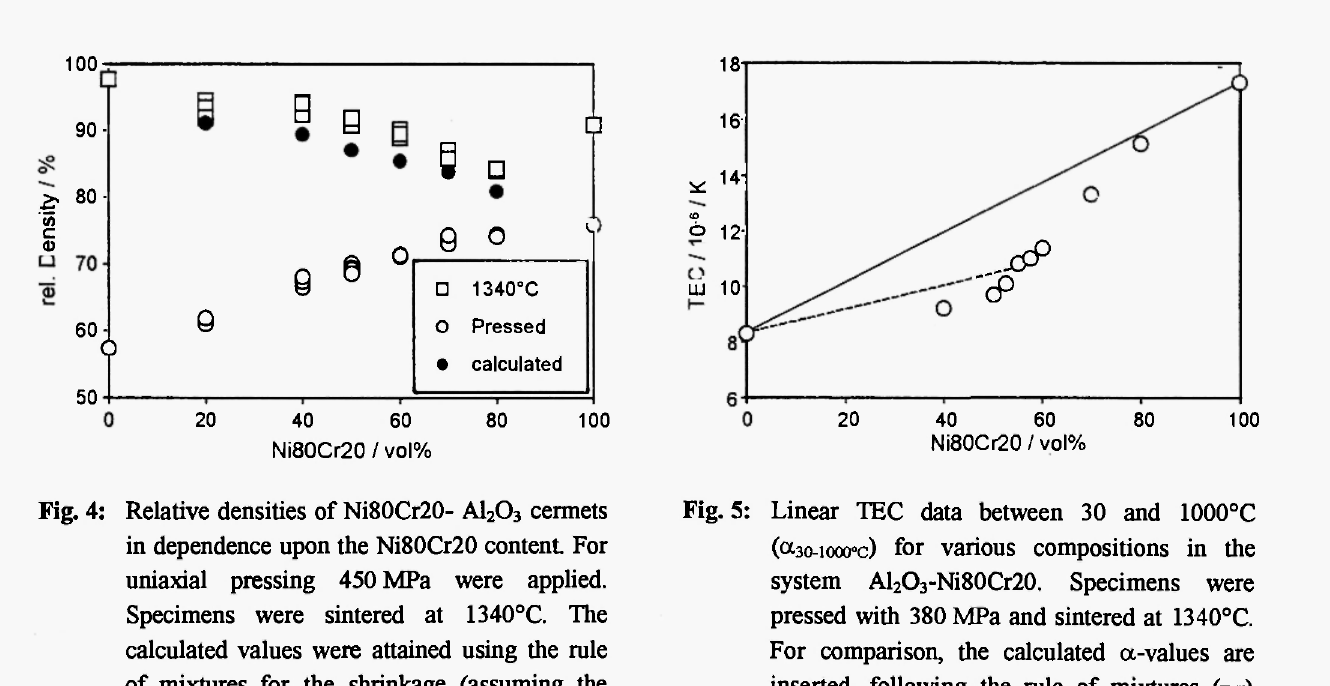
Fig. 4: Relative densities of Ni80Cr20- AI2O3 cermets in dependence upon the Ni80Cr20 content For uniaxial pressing 450 MPa were applied.